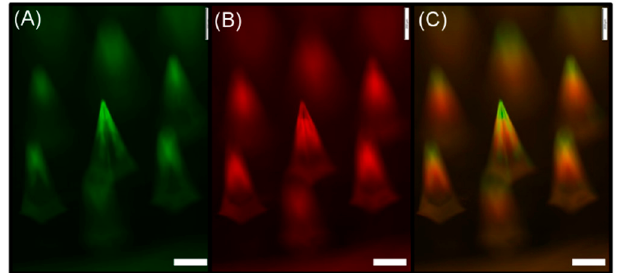
Figure 2. Fluorescence microscopy images of the fabricated layered microneedles. ( A ) Coumarin 314 (green)-loaded poly(lactic- co -glycolic acid) (PLGA) layer, ( B ) sulforhodamine B (SRB) (red)-loaded